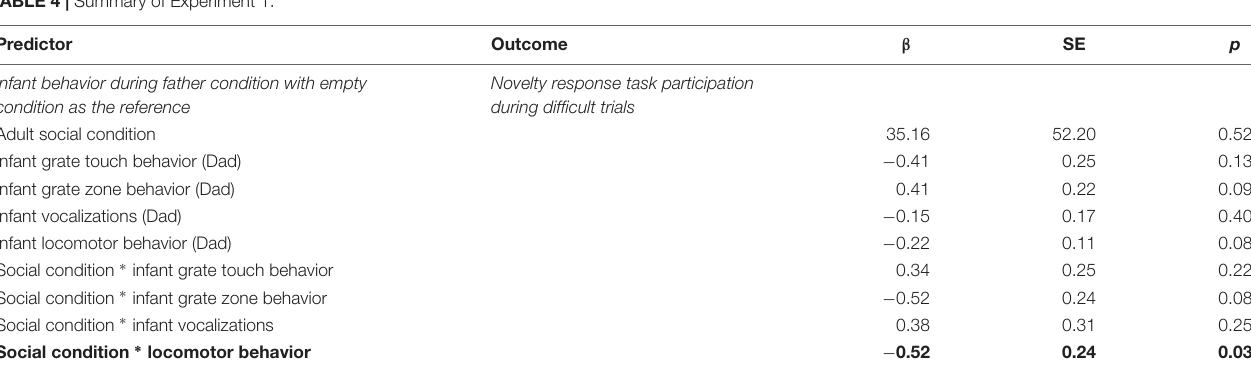
TABLE 4 | Summary of Experiment 1.